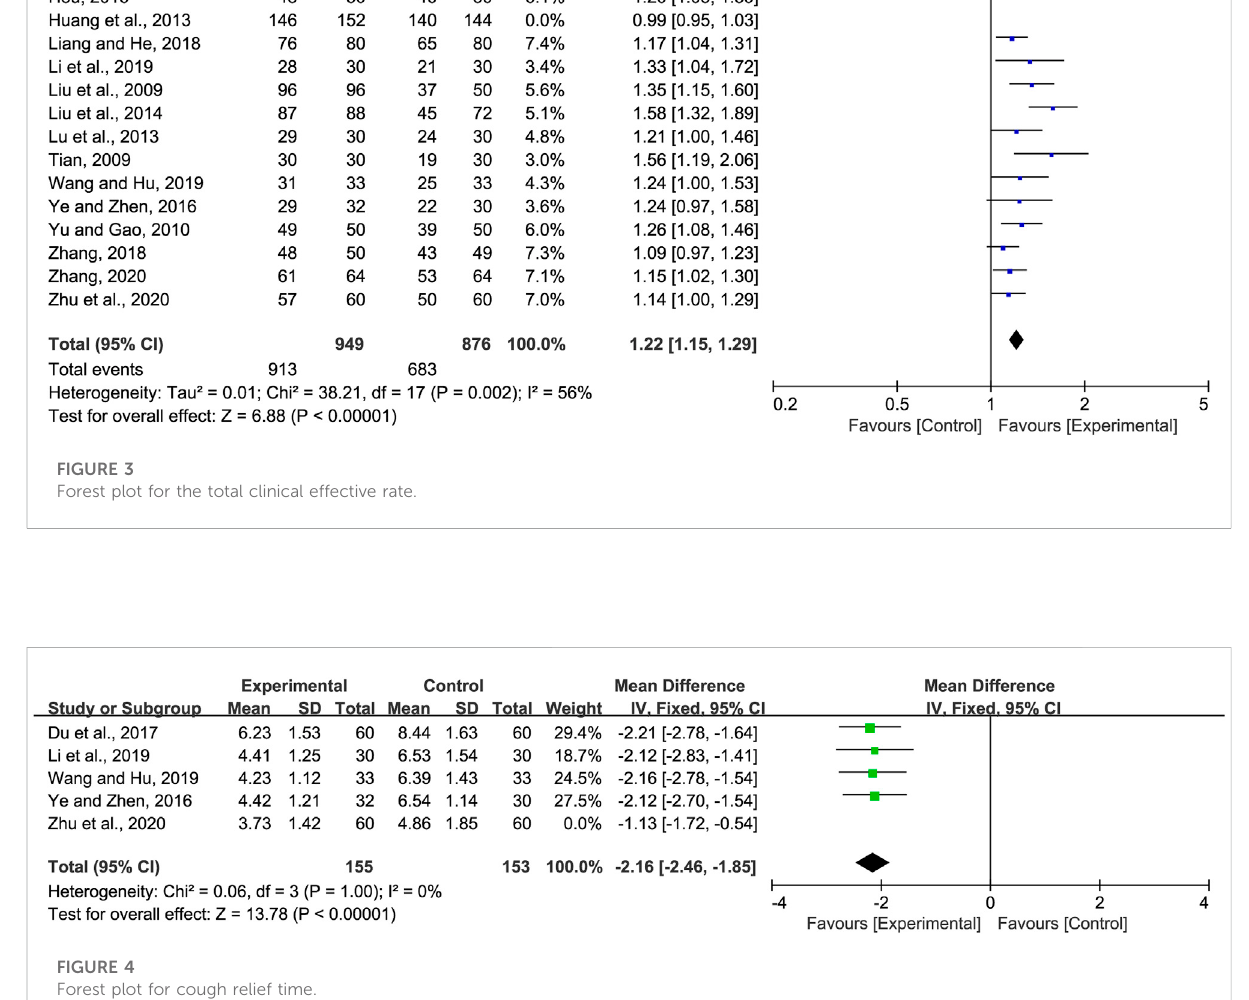
FIGURE 4 Forest plot for cough relief